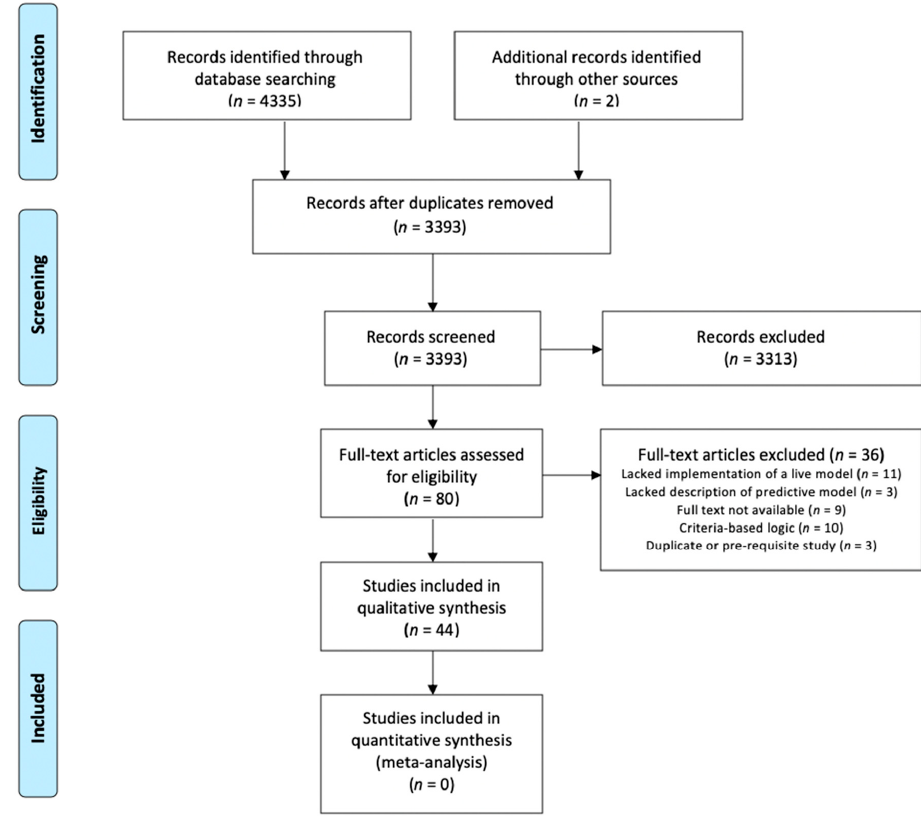
Figure 1. PRISMA flow diagram describing the study selection process.